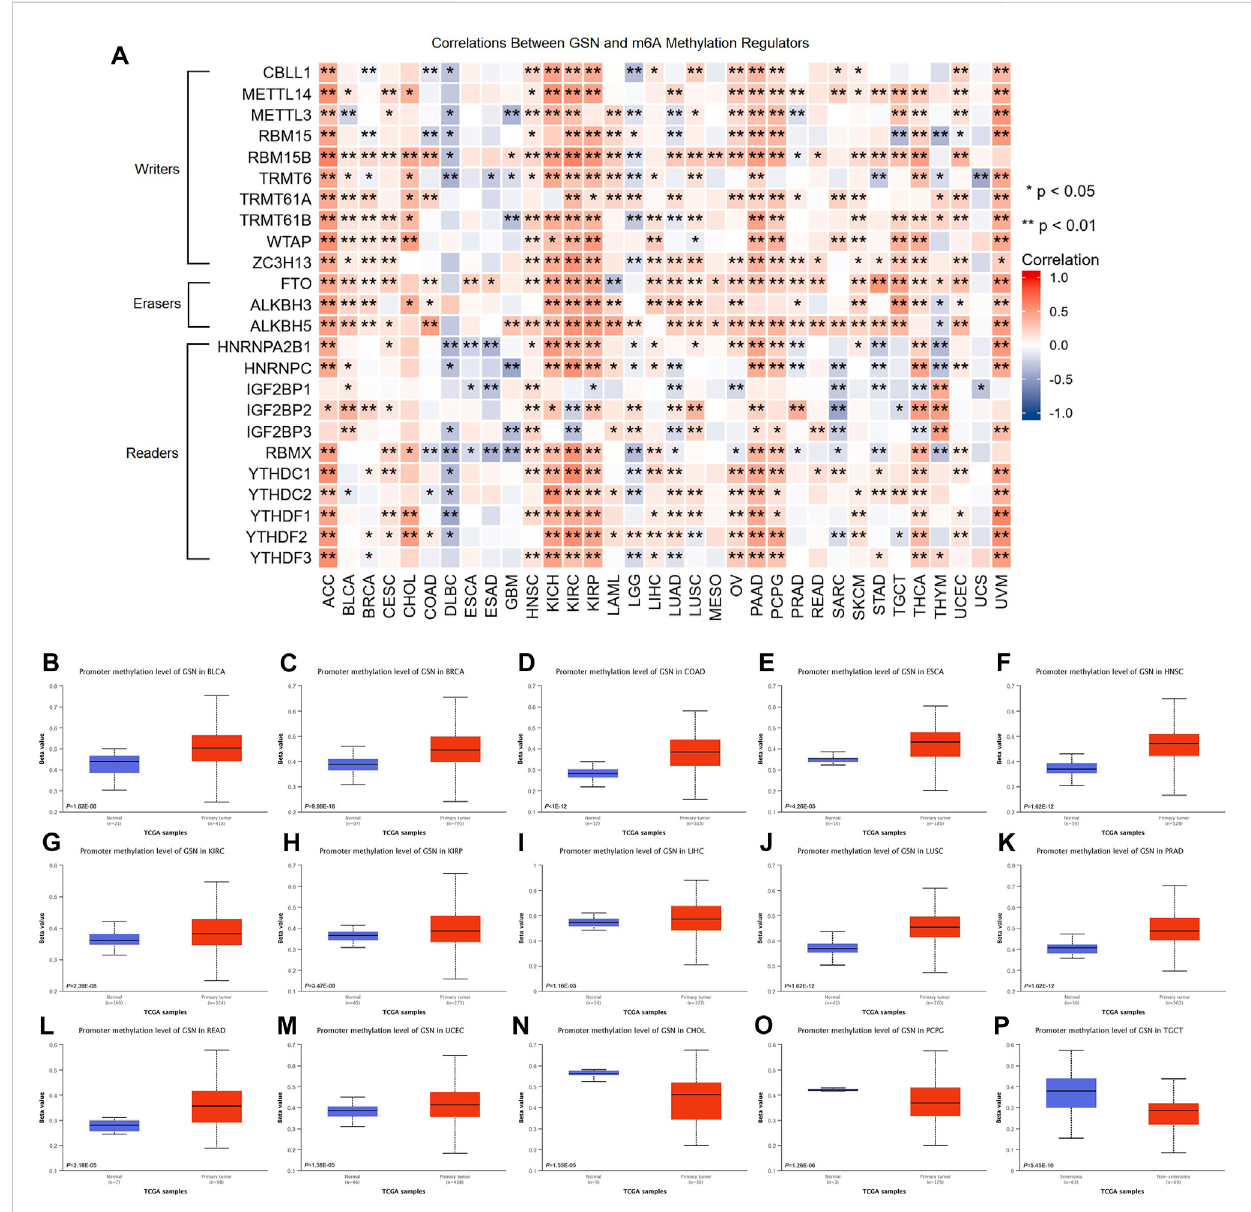
FIGURE 8 Epigenetic methylation analysis of GSN. (A) The correlation between the expression of GSN mRNA and m6A methylation regulatory factors in multiple cancers. Differential promoter methylation level (beta values) of GSNin normal tissues and tumors based on UALCAN,including BLCA (B) , BRCA (C) , COAD (D) , ESCA (E) , HNSC (F) , KIRC (G) , KIRP (H) , LIHC (I) , LUSC (J) , PRAD (K) , READ (L) , UCEC (M) , CHOL (N) , PCPG (O) , and TGCT (P)